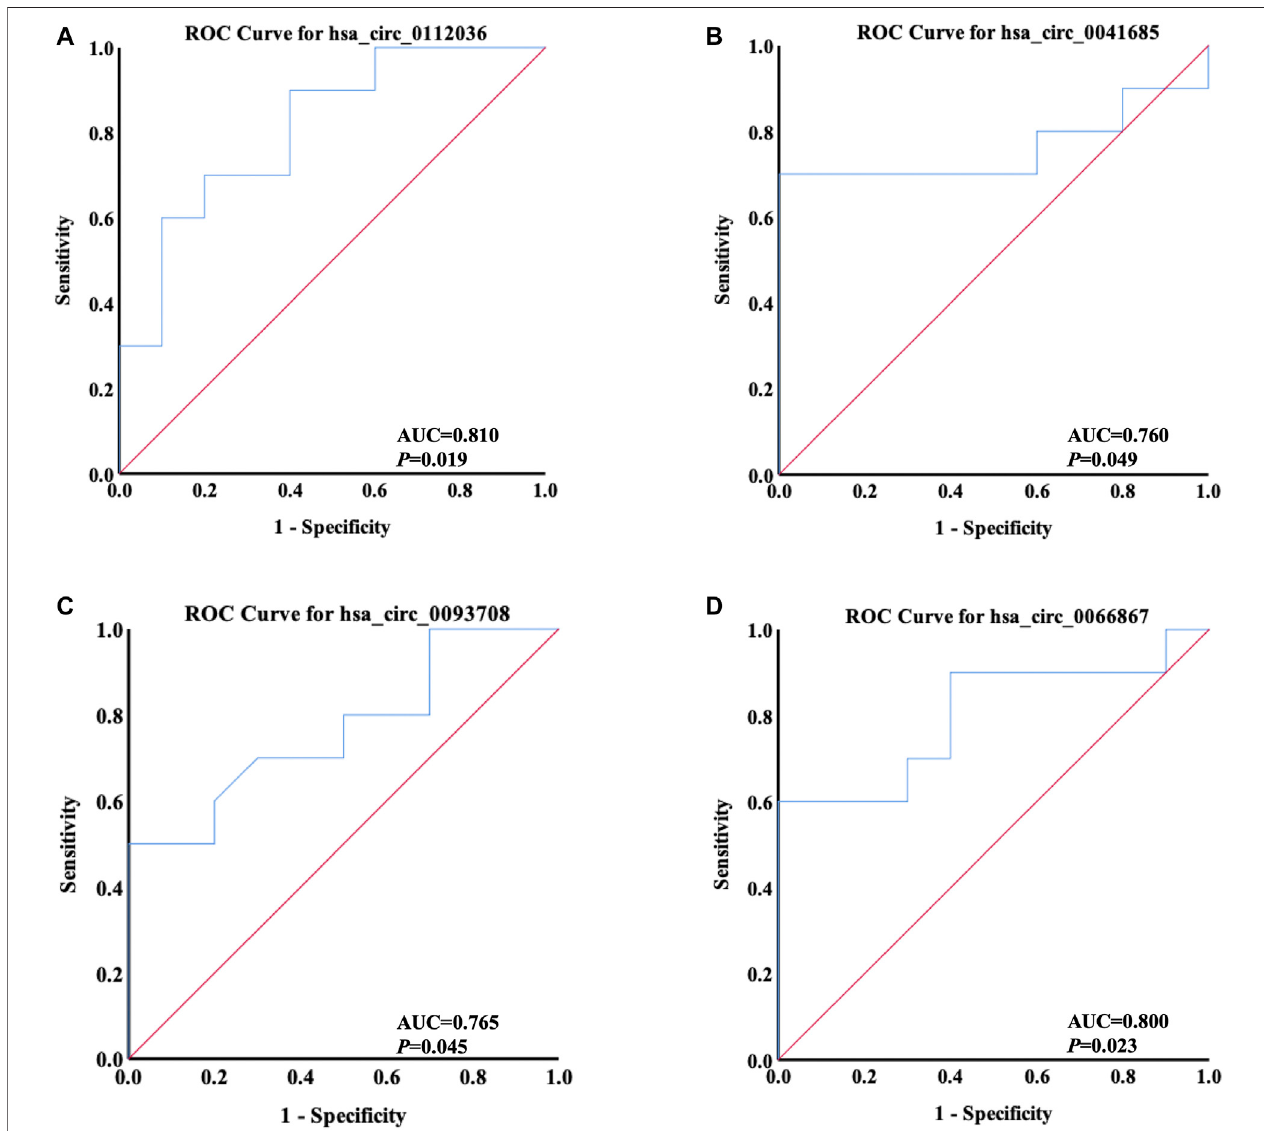
FIGURE 9 | ROC curves of four differentially quanti fi ed circRNAs veri fi ed by qRT-PCR, including (A) hsa_circ_0112036, (B) hsa_circ_0041685, (C) hsa_circ_0093708,and (D) hsa_circ_0066867 ( n =10).Thered diagonal lines inthegraphsrepresentthediagnostic threshold valueofcircRNAsforAIS(AUC=0.500).